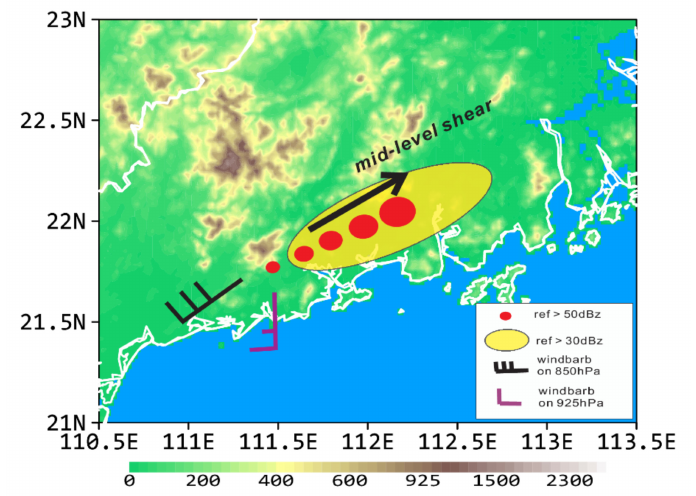
Figure 14. A conceptual model for the linear-shaped MCSs with background topography of South China.